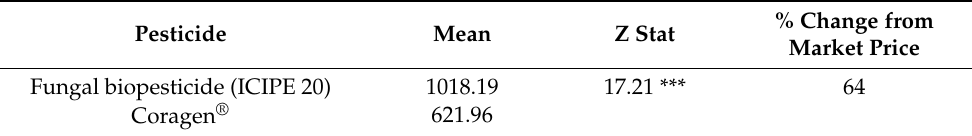
Table 4. The agro-dealers’ mean willingness to pay and mean premium price for biopesticide and commonly used synthetic pesticide.